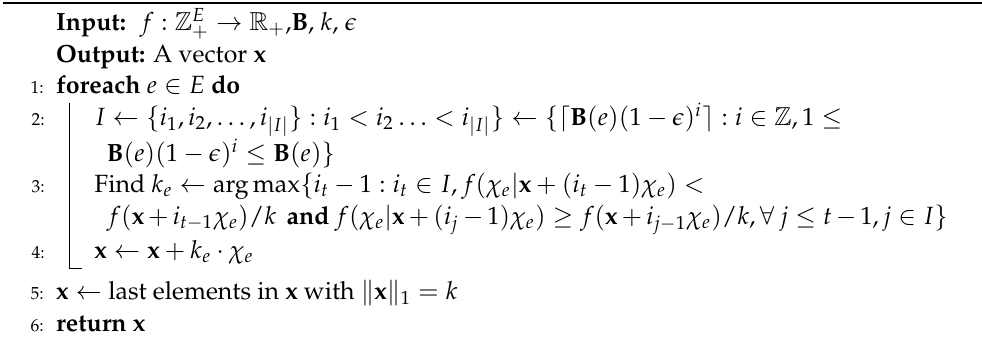
Algorithm 3: ( 1/4 ) -approximation algorithm (Stepping-Stone